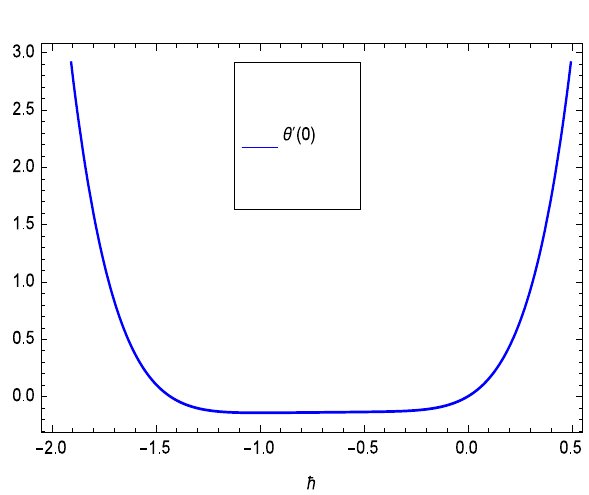
Figure 2. h curve of f ( ζ ).